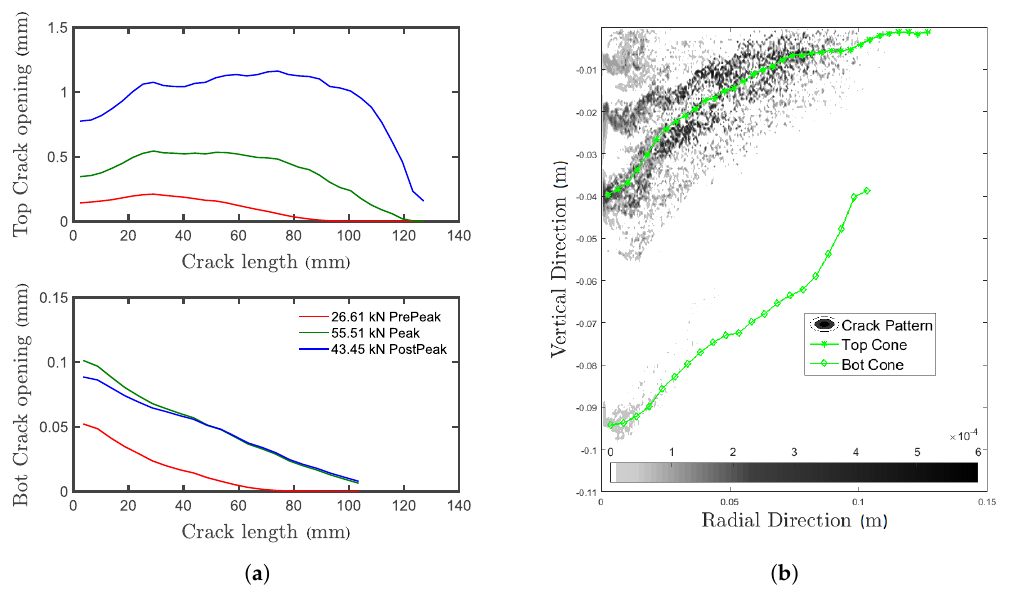
Figure 14. ( a ) Crack opening along the Top and Bot concrete cones of numerical simulations and ( b ) related contour plot of the crack